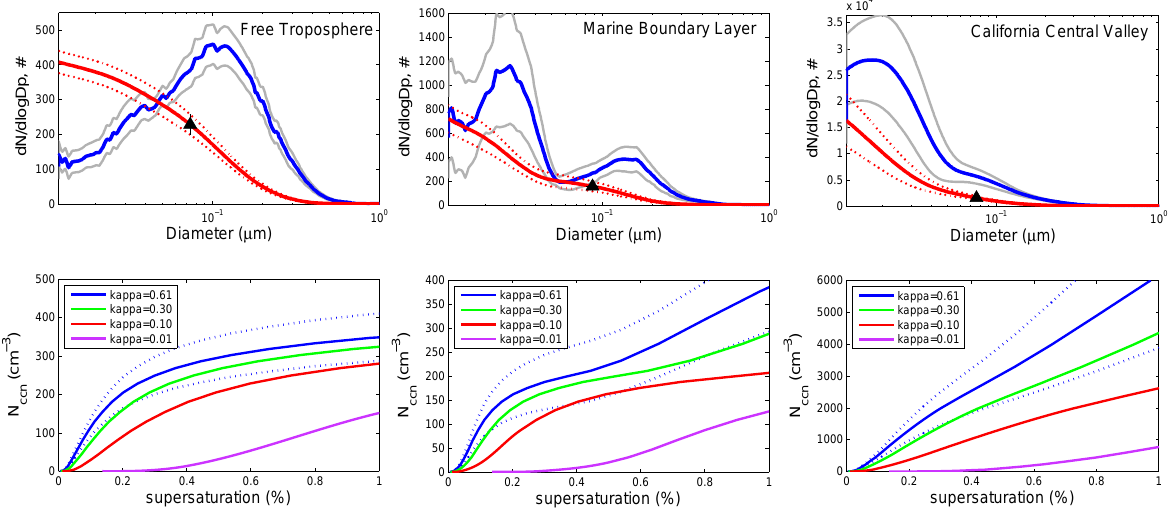
Fig. 5. Average of size distributions and calculated CCN spectra for all level legs in the (a) free troposphere, (b) marine boundary layer, and (c) California Central Valley. Upper panels: blue lines show average size distributions measured by SMPS. Grey lines indicate the 1-sigma standard deviation of the mean of the size distributions for the different level legs ( σn − 0 . 5 ) . The red lines represent the integrated number concentrations of the size distributions and variation ( σn − 0 . 5 ) . The average CCN concentrations and variation ( σn − 0 . 5 ) are indicated by a black triangle and vertical line. Lower panels: CCN spectra for each air mass using the average size distributions and plotted for aerosol compositions corresponding to four different values for κ . The error in the CCN spectrum attributed to the variance in size distribution is shown for the κ =0.61 (dotted blue